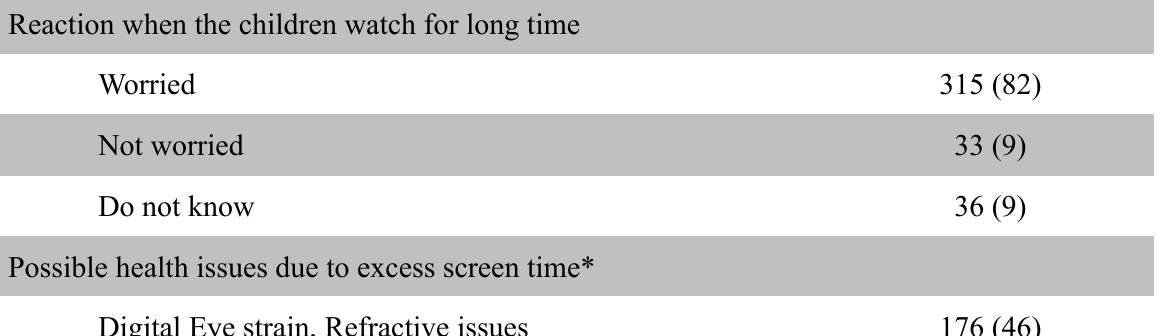
Table 2: Parental response towards screen viewing during covid-19 (n=384) Parental